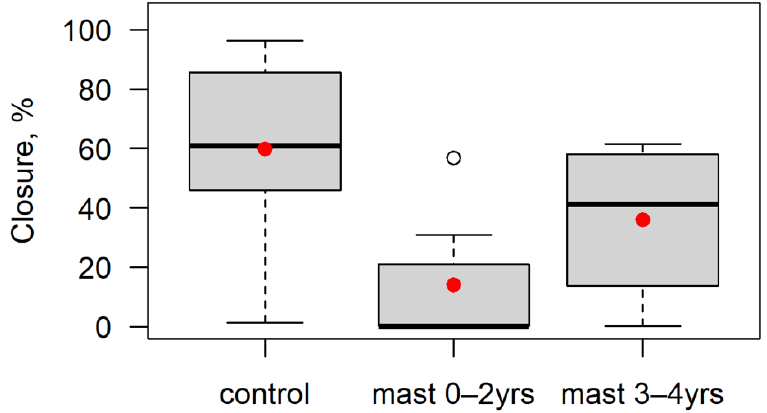
Figure 3. Boxplots of vegetation closure (%) measured from a height of 1.5 m for 0–2 years post mastication, 3–4 years post mastication and control. The mean is indicated by the red dot.